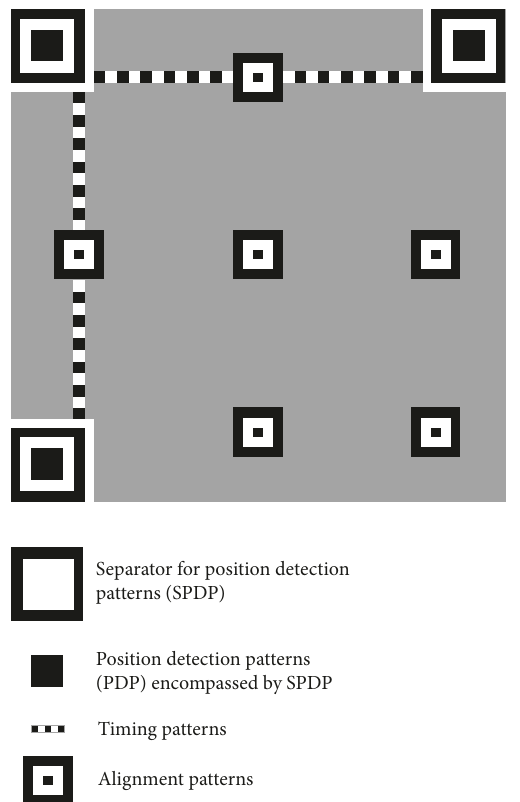
Figure 1: Structure of generic QR code with finding (PDP and SPDP), alignment, and timing